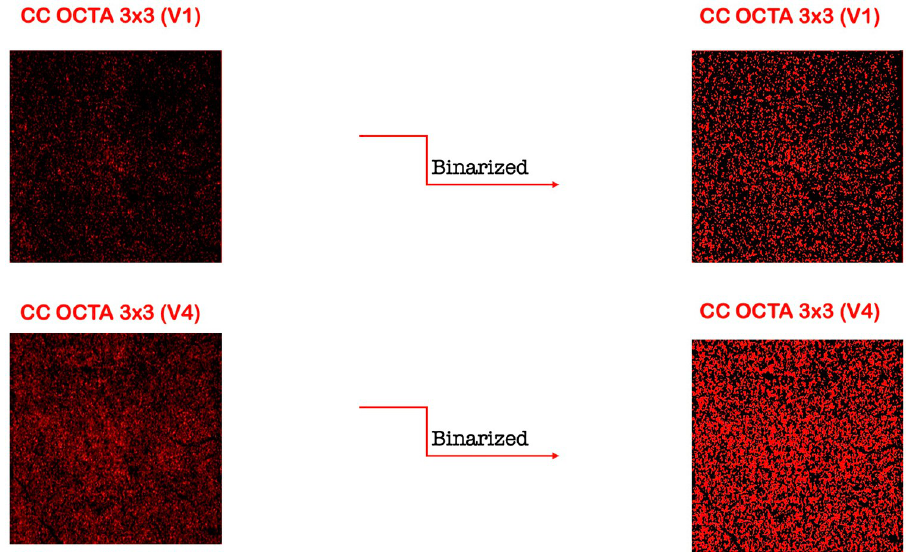
Fig 3. Representation of the OCTA assessment of the choriocapillaris (CC). The CC was investigated in two different scans: (i) 3x3-mm single volume scan (V 1 ) (top left), and (ii) 3x3 multiple-volume scan (V 4 ) (bottom left). The CC binarized (right) image was analyzed to investigate CC flow deficits.